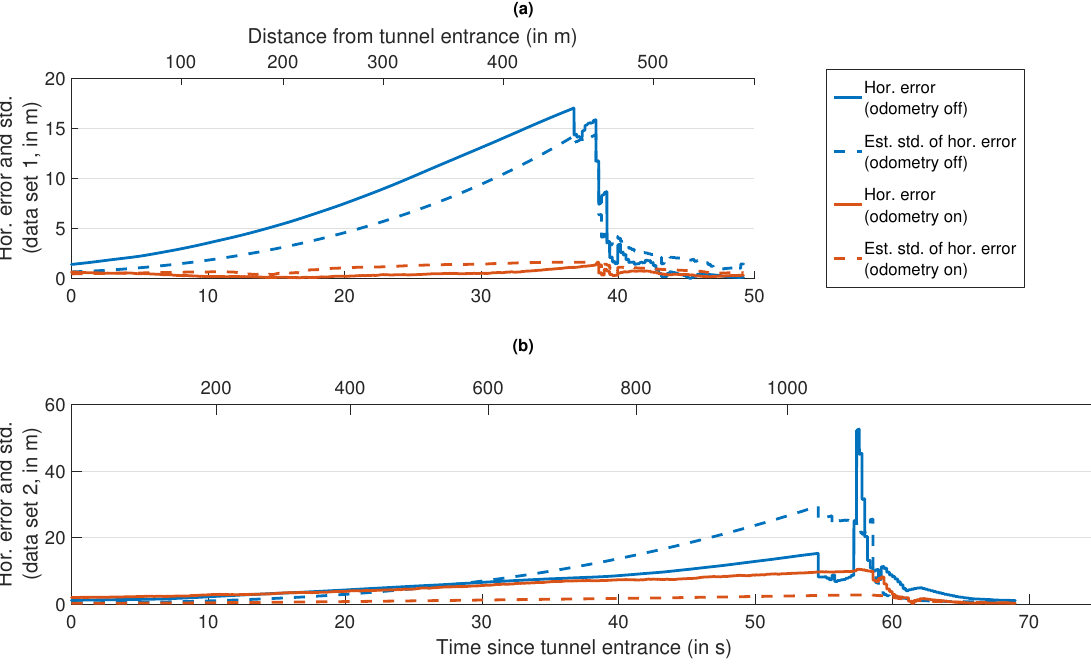
Figure 6. Horizontal position error and its estimated standard deviation during passages through different tunnels. Multi-frequency/multi-constellation algorithm, with and without odometry